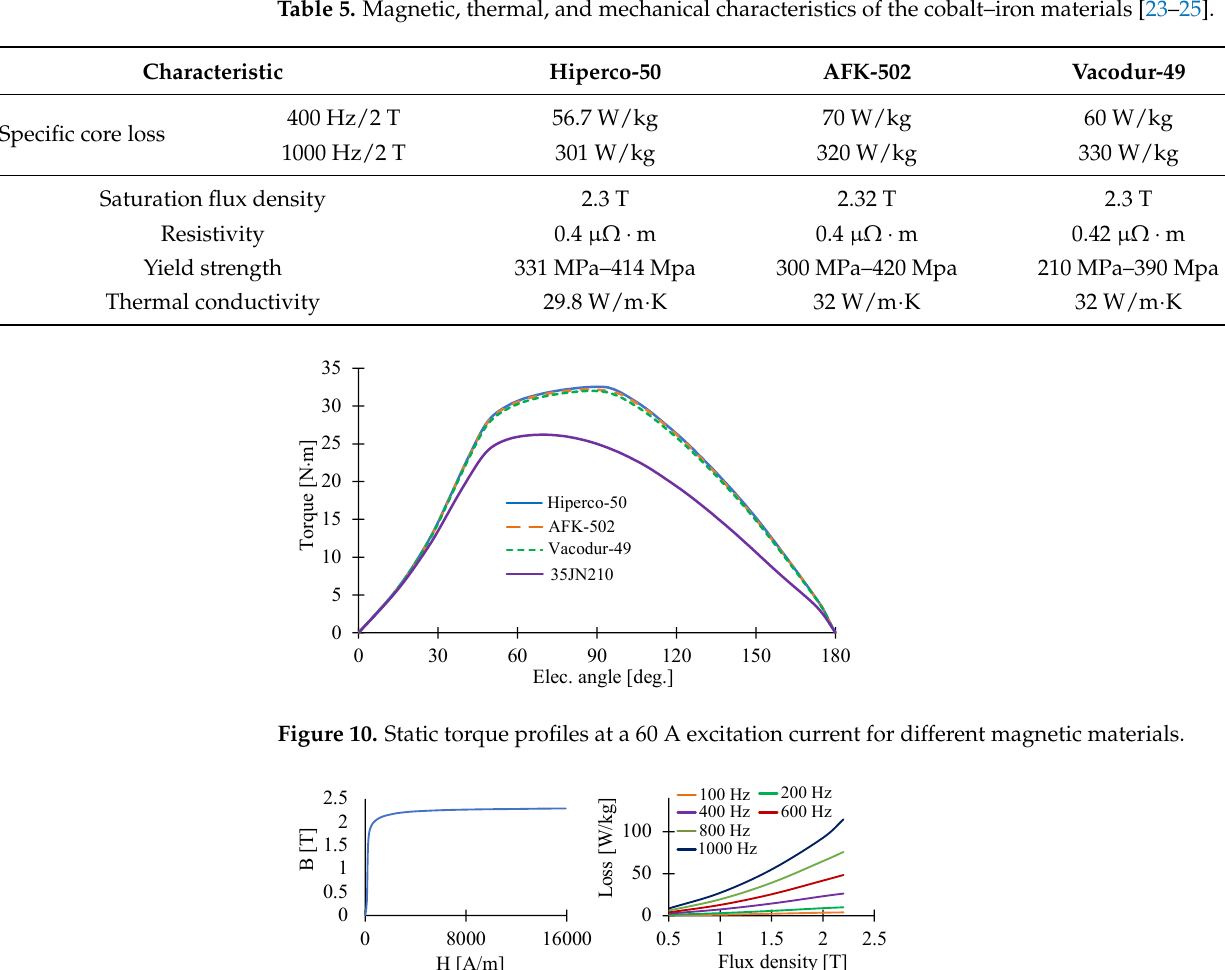
Table 5. Magnetic, thermal, and mechanical characteristics of the cobalt–iron materials [23–25].